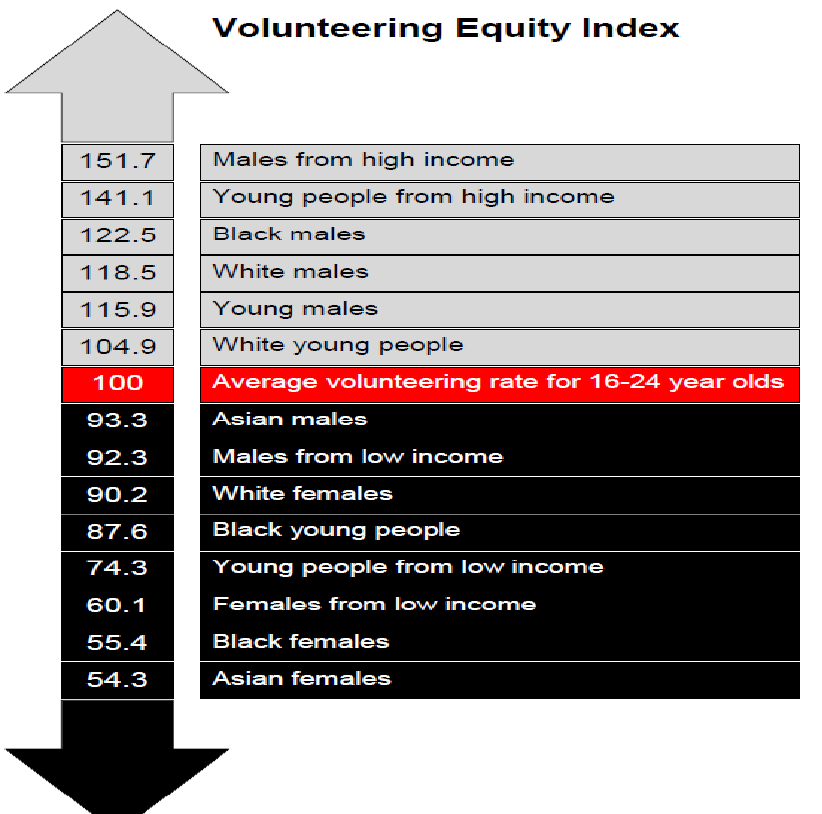
Figure 2. Volunteering Equity Index: Regular volunteering by different groups (sources: Sport England (2009) and Street Games